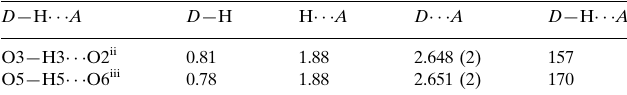
Hydrogen-bond geometry (A˚ , (cid:2)